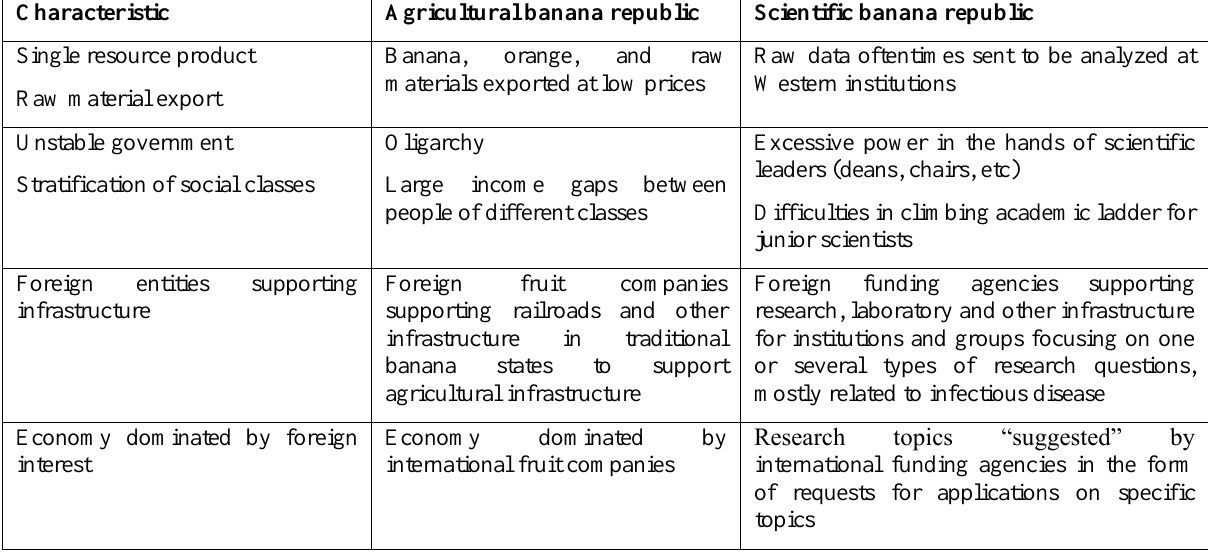
Table 1. Agricultural banana state vs. scientific banana state